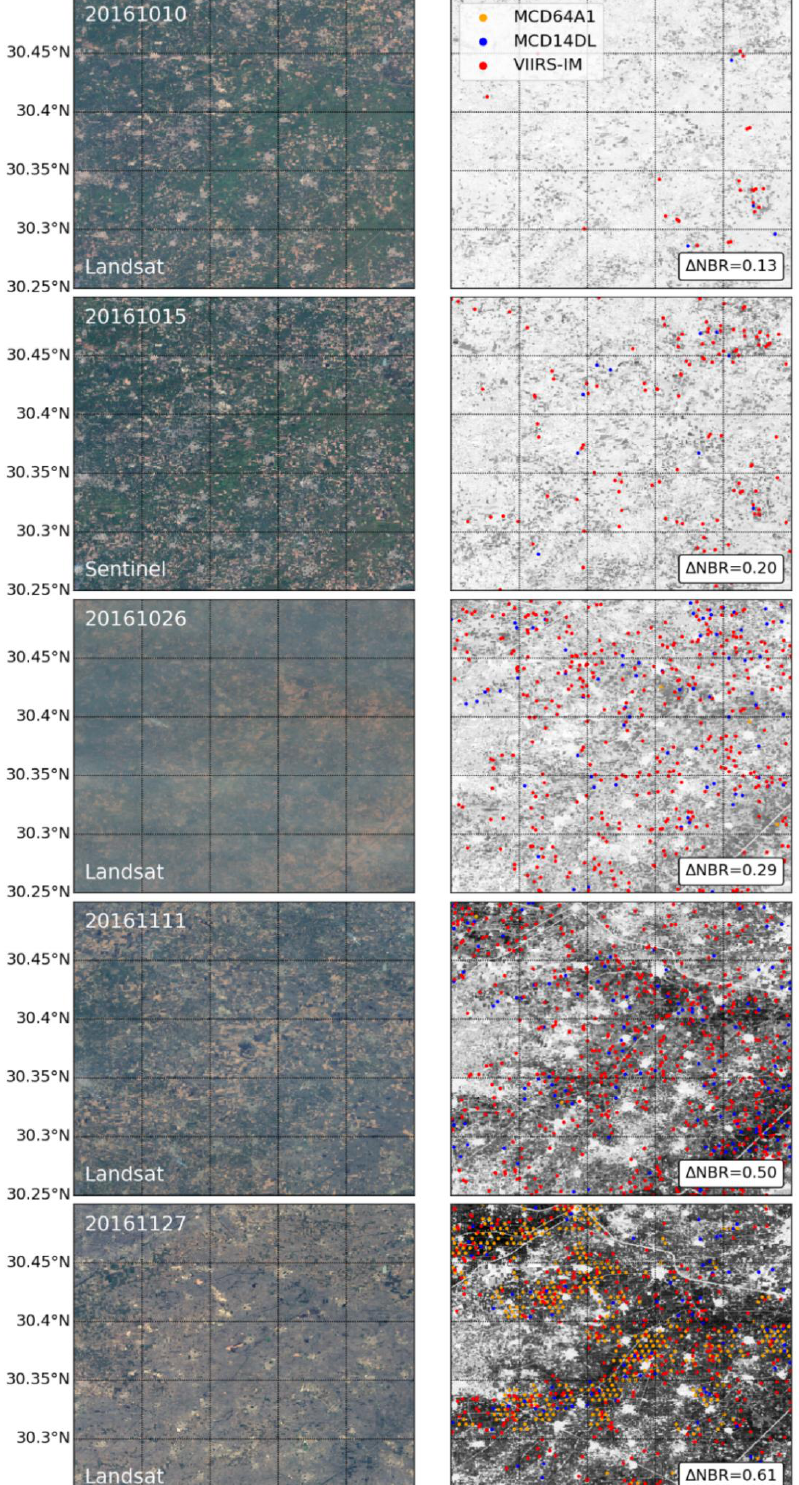
Figure 7. Detail of a 0.25° GFED grid cell centered at 30.375° N, 74.875° E, Punjab, India and imaged repeatedly over the October to November 2016 burning season. ( Left column ) true colour composites derived from Landsat/Sentinel-2 imagery, and ( right column ) ∆𝑁𝐵𝑅 map overlaid with burned area and AF detection data from MODIS and VIIRS collected during the interval between each Landsat/Sentinel-2 image. ∆𝑁𝐵𝑅 caption reports mean ∆𝑁𝐵𝑅 of the whole grid cell, and the amount of burned area present within the grid cell can be seen increasing from the 10 October 2016 to the 27 November 2016.